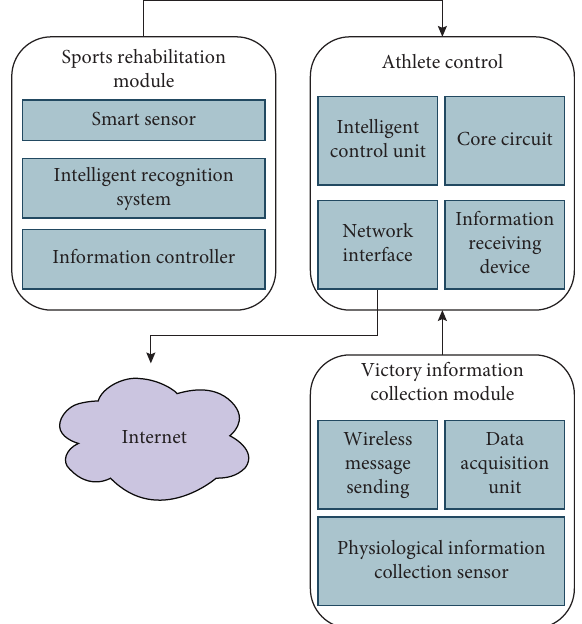
Figure 14: The structure diagram of local services in the rehabilitation training